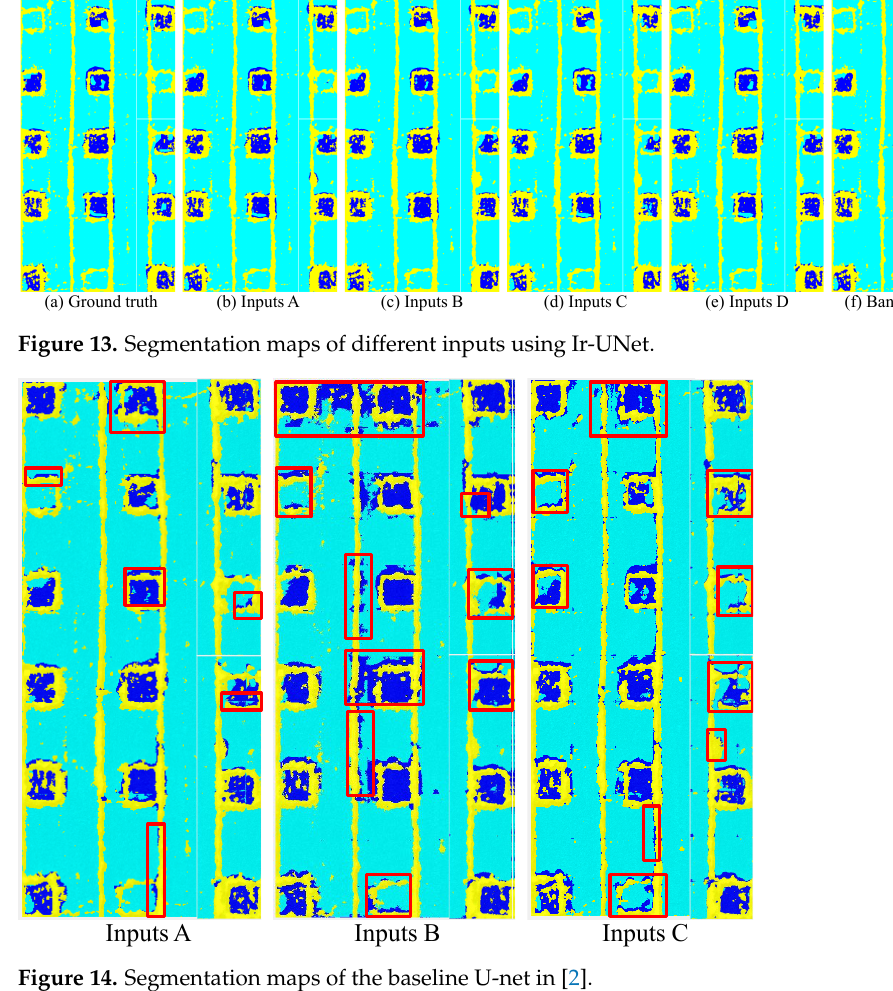
Figure 14. Segmentation maps of the baseline U-net in